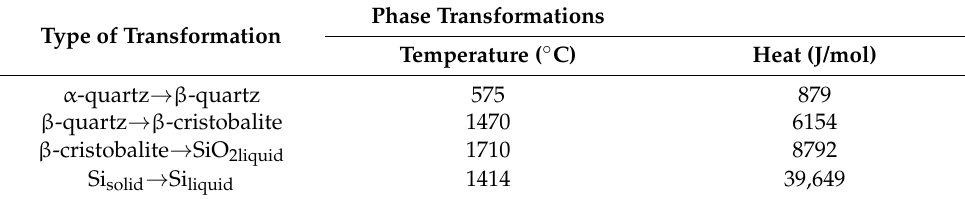
Table 1. Phase transformations of SiO 2 and Si [2,3].